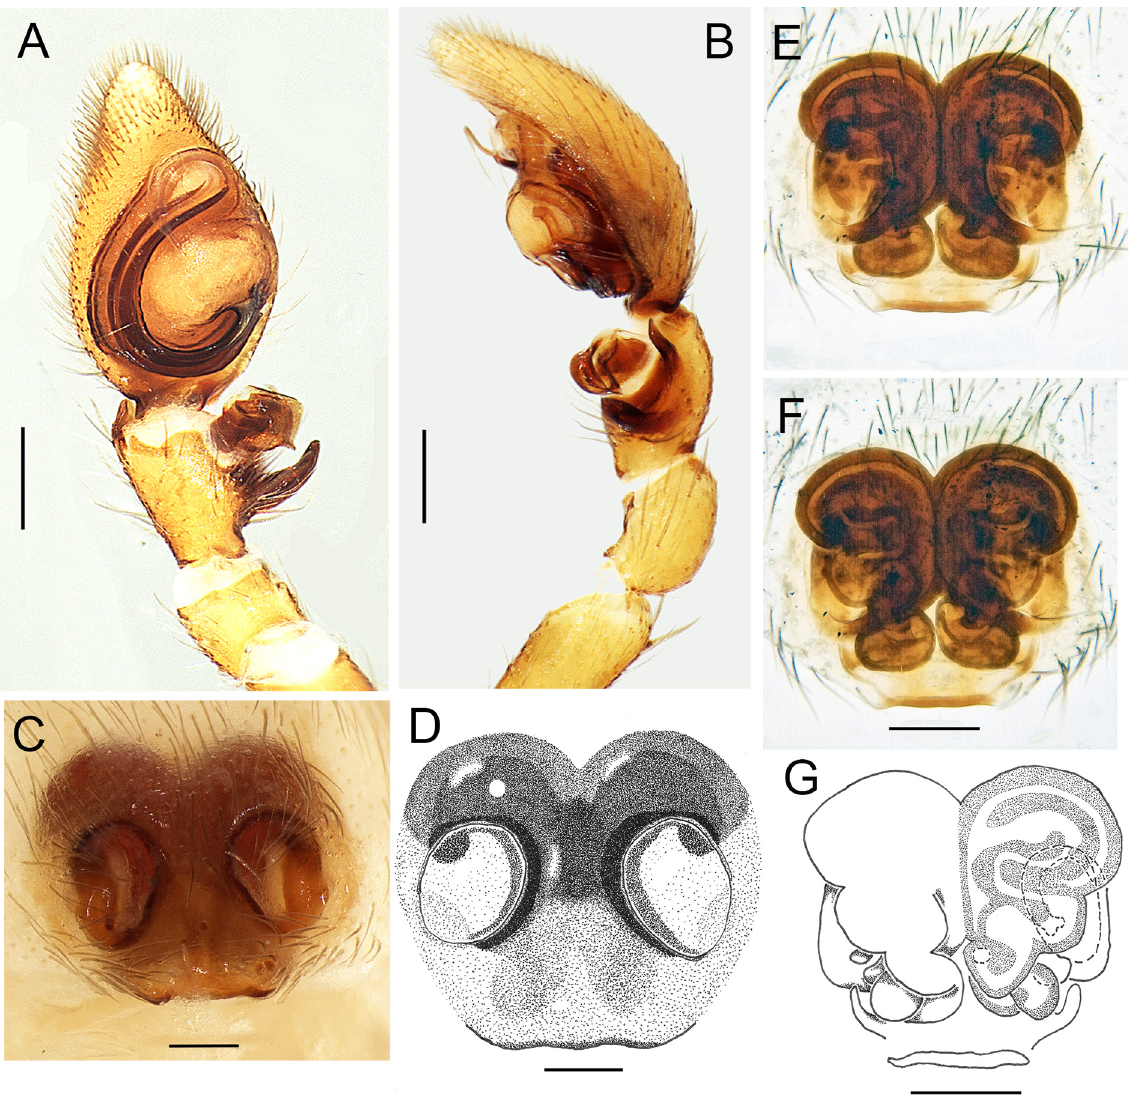
Fig. 35. Andromma raffrayi Simon, 1899. A–B . Male, BE_RMCA_ARA_Ara 220165 from Kwazulu- Natal. C–G . Female, BE_RMCA_ARA_Ara 168628 from Namibia. A . ♂, left palp, ventral view. B . Same, retrolateral view. C–D . Epigyne, ventral view. E . Same, cleared, ventral view. F–G . Same, dorsal view. Scale bars: 0.1